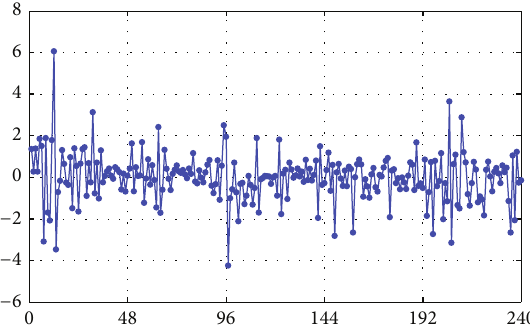
Figure 3: The detailed values of w in the hyperplane.